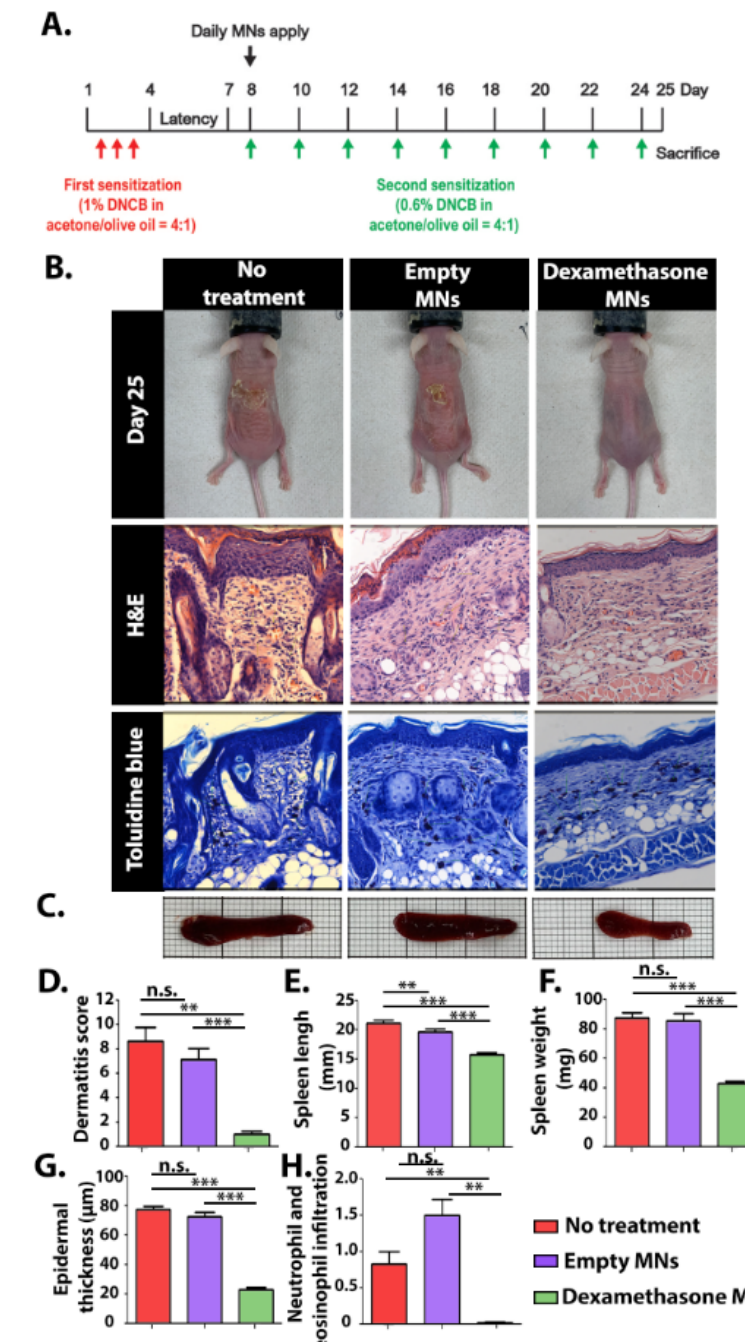
Figure 5. ( A ) Schematic representation of the experimental procedure. ( B ) Representative photos of the experimental mice after 25 days and histological images (magnification, × 400). ( C ) Representative images of the experimental spleens. In vivo evaluation at day 25: ( D ) dermatitis score, ( E ) spleen length, ( F ) spleen weight, ( G ) epidermal thickness, and ( H ) neutrophil and eosinophil infiltration. Data are means and SD of n = 6, ** p < 0.005, *** p < 0.0001, n.s.—non